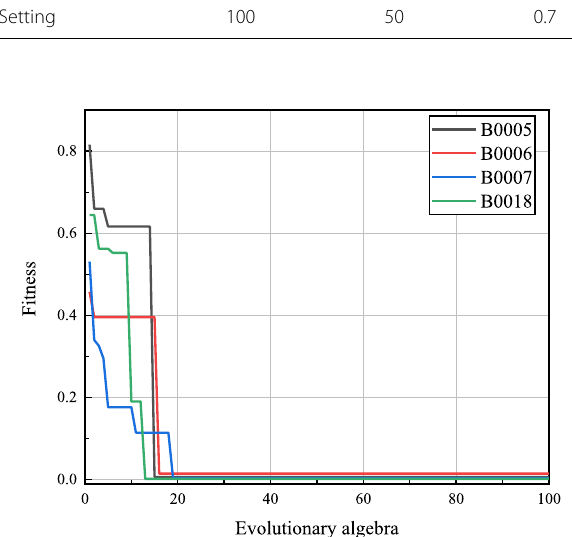
Fig. 11 The curve of fitness value changing with the number of iterations